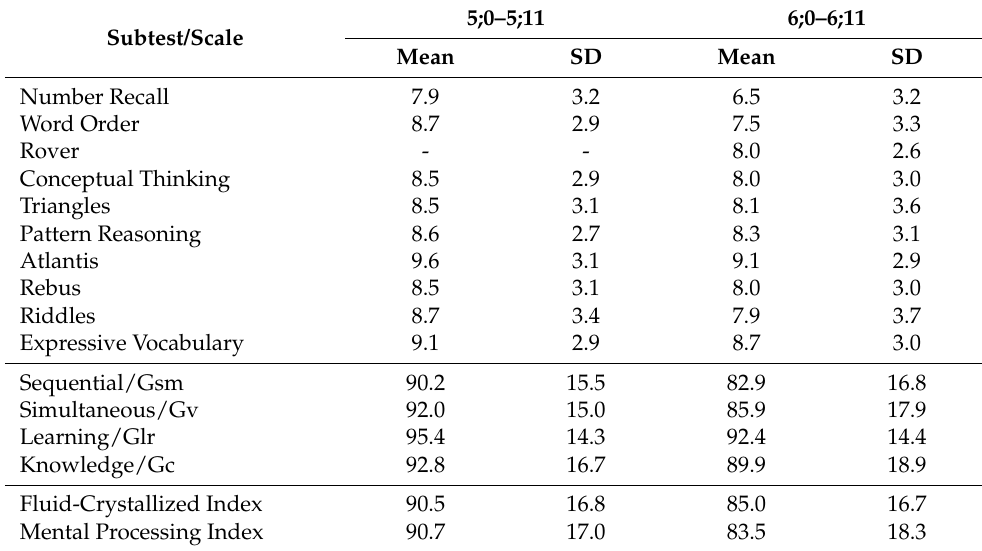
Table 4. Means and standard deviations (SD) for KABC-II subtests, scales, and global